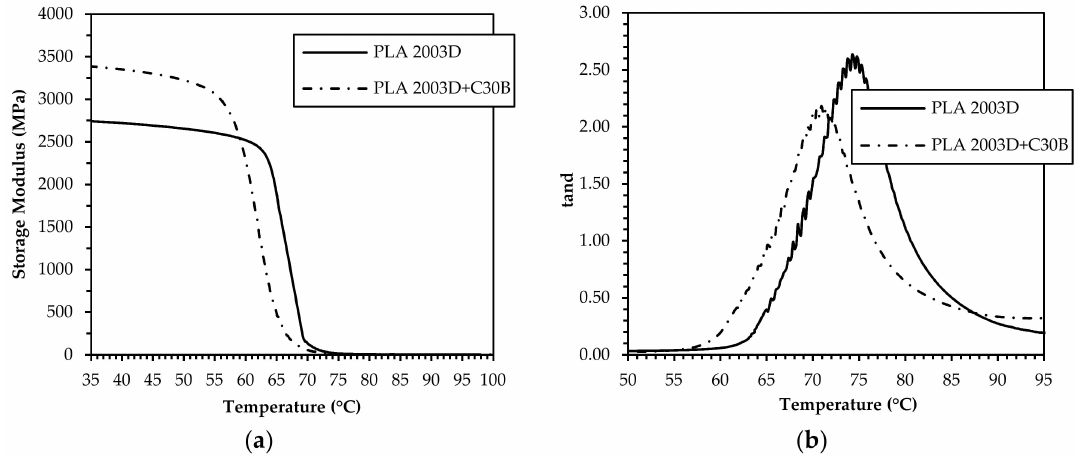
Figure 4. Storage modulus ( a ) and tan δ ( b ) of PLA 2003D and PLA 2003D+C30B